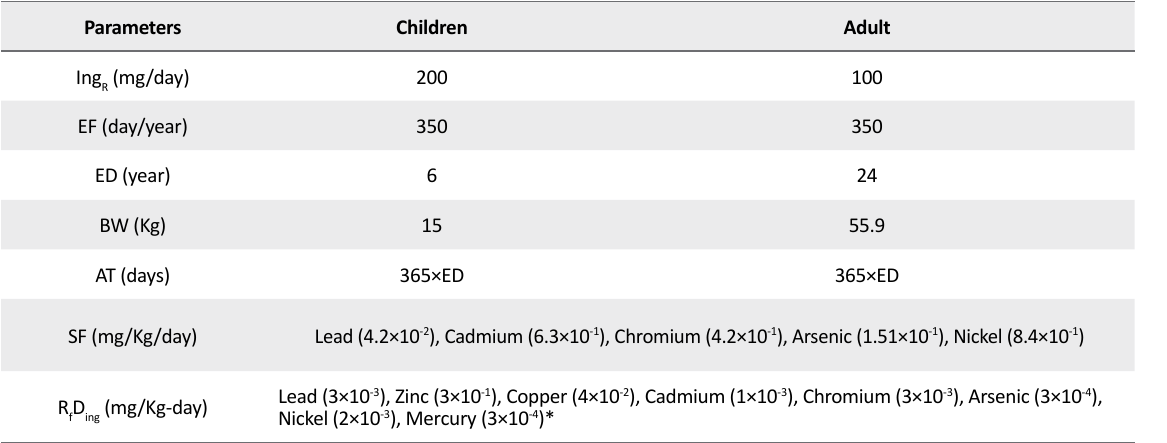
Table 1. Values of heavy metals in health risk assessment relationships [25] AdultChildrenParameters